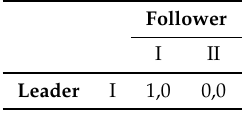
Table 9. A simple bi-matrix game without a secure incentive